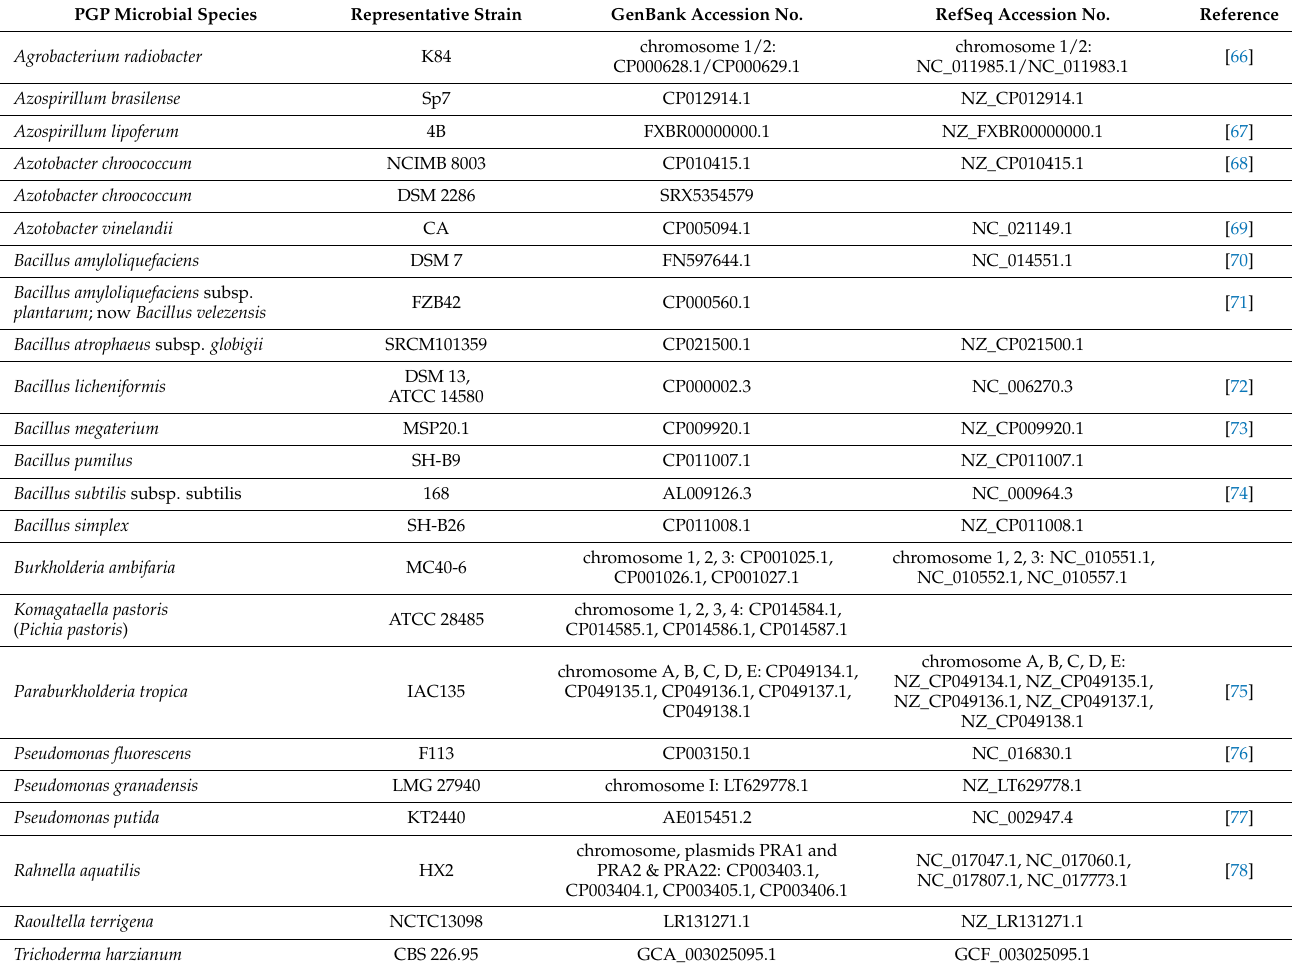
Table 2. Representative Strains of Selected PGPMs Including Corresponding GenBank and RefSeq Accession Numbers for Their